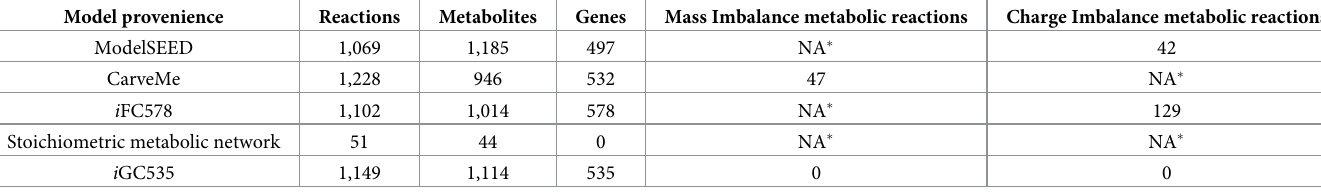
Table 1. Comparative table of the properties of the genome-scale model of Ne ( i GC535) and other